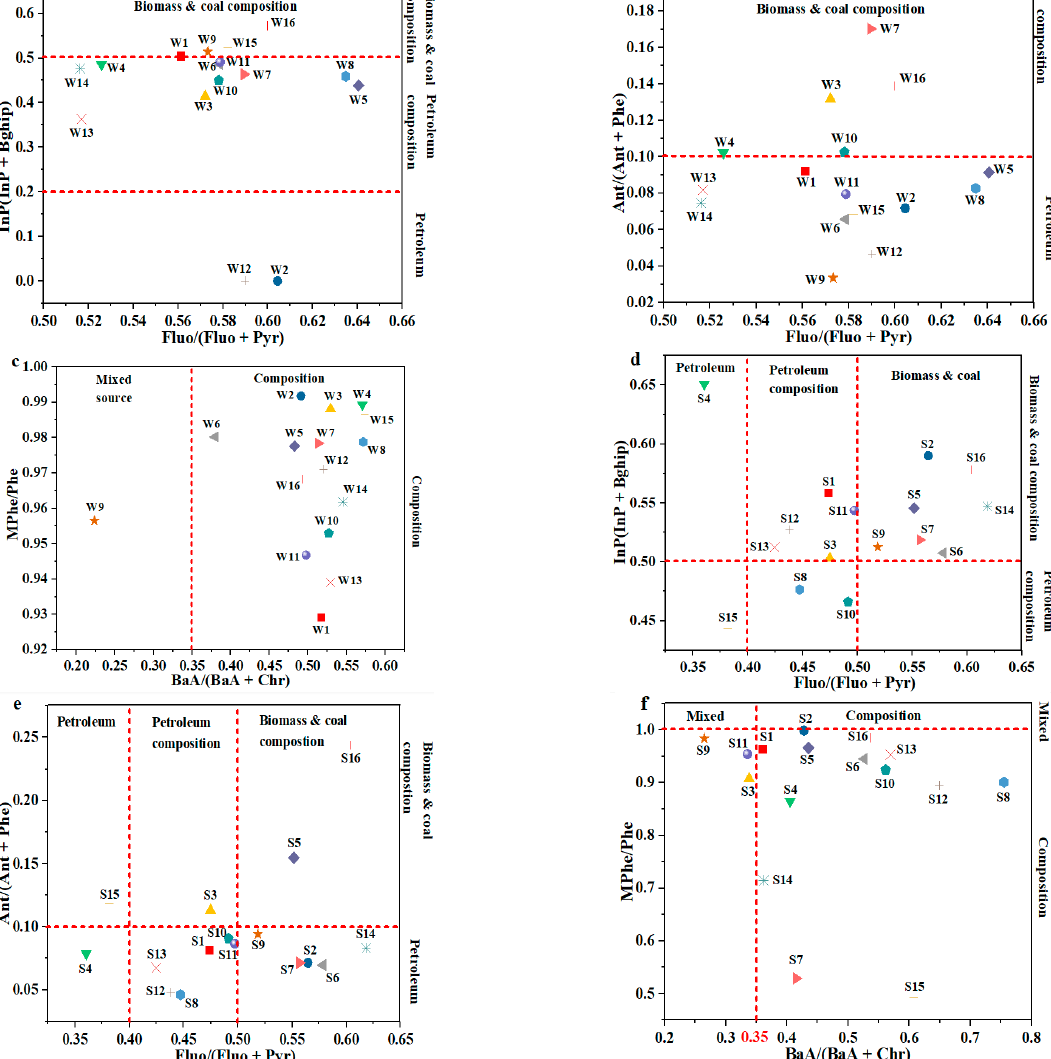
Figure 2. Plots showing PAHs and MePAHs isomeric ratios Flu/(Flu + Pyr) versus: InP/(InP + BghiP), Ant/(Ant + Phe), and BaA/(BaA + Chr), versus: MPhe/Phe, for water ( a – c ), and sediments ( d – f ) in Songhua River North China.